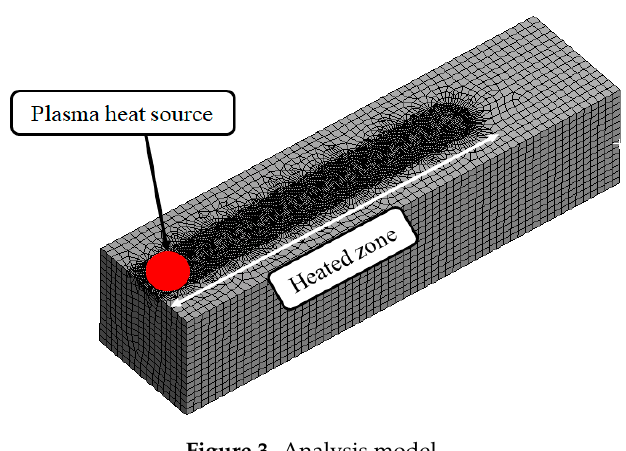
Figure 3. Analysis Figure 3. Analysis model.